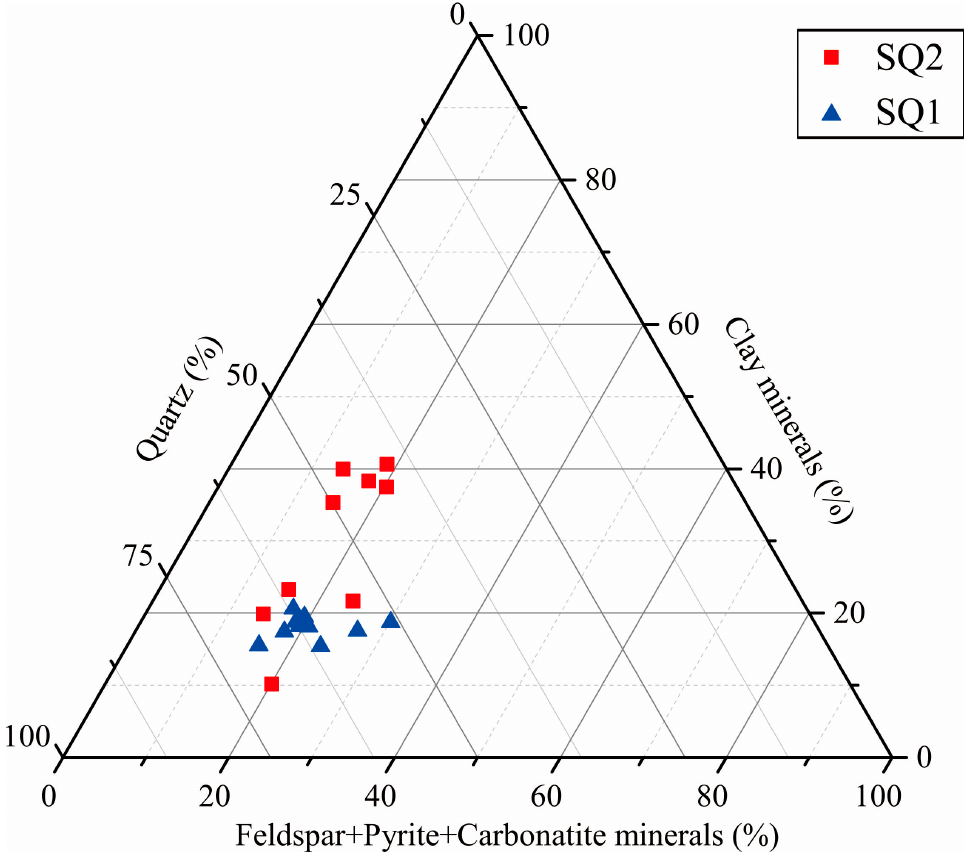
Figure 6. Ternary plot of the mineral compositions of SQ1 and SQ2.